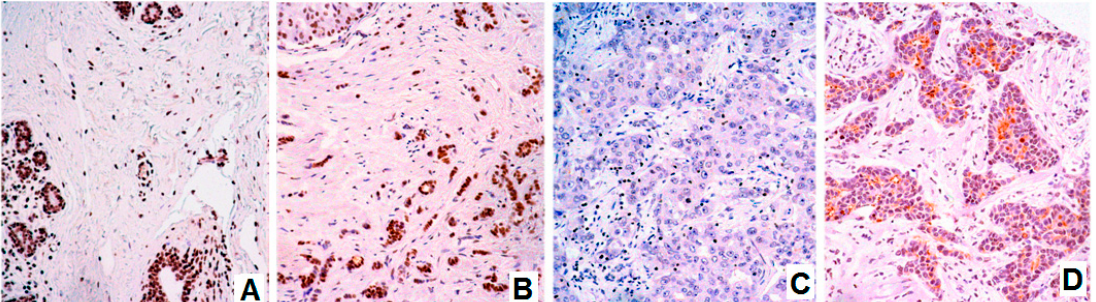
Figure 2. BARHL1 expression in normal and neoplastic breast tissue. ( A ) Ductal epithelial and basal cells showing positive staining, as well as stromal cells. ( B ) Positive staining for a lobular breast carcinoma. ( C ) Negative expression in a ductal poorly-differentiated breast carcinoma. ( D ) Well-differentiated breast carcinoma. Note: cytoplasmic apical lumen staining. ×20 original magnifications.